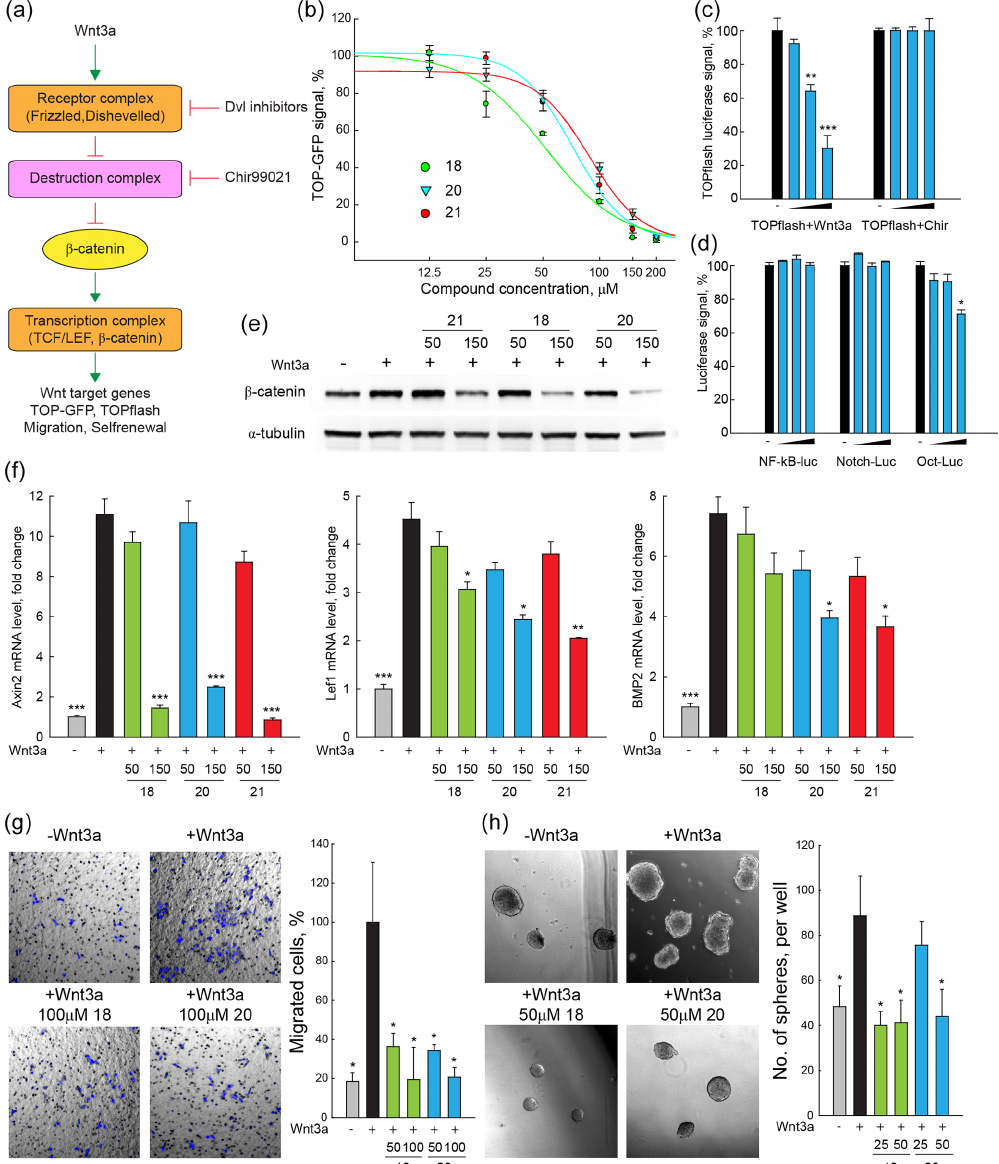
Figure 2. DVL inhibitors antagonize Wnt signalling and Wnt-related properties of cancer cells induced by Wnt3a. (a) Scheme of Wnt signalling pathway. Important components of the Wnt signalling pathway are schematically presented. Wnt3a treatment increases the tran- scription of Wnt targets, enhances signals of TOP-GFP and TOPflash assays, and promotes Wnt-related biological properties of cancer cells. (b) TOP-GFP reporter assays were performed with HEK293 reporter cell line. Compounds 18 , 20 , and 21 inhibited Wnt3a-induced Wnt ac- tivation in a dose-dependent manner with IC 50 of 50–75µM. (c, d) TOPflash assays stimulated with Chir99021 and reporter assays of other pathways were used to evaluate the specificity of compound 20 . Compound 20 specifically inhibited Wnt3a-induced Wnt activation and had no or a mild effect on Chir99021-induced Wnt activation and other signalling pathways including NF– κ B, Notch, and Oct4. (e) β -Catenin protein levels were detected with Western blotting in HeLa cells. Compounds 18 , 20 , and 21 (150µM) inhibited accumulation of β -catenin in HeLa cells treated with Wnt3a. (f) The mRNA levels of Wnt target genes (Axin2, LEF1, and Bmp2) in HeLa cells were measured with quantitative real-time PCR. Compounds 18 , 20 , and 21 (150µM) reduced the transcription of Wnt target genes that are enhanced by Wnt3a treatment in HeLa cells. (g) Cell migration of SW480 cells after Wnt3a treatment was assessed by trans-well assays. Compounds 18 and 20 (50–100µM) reduced the migration of SW480 cells enhanced by Wnt3a. (h) SW480 cells were cultured in serum-free non-adherent conditions to evaluate the self-renewal property enhanced by Wnt3a treatment. Compounds 18 and 20 (25–50µM) reduced sphere formation of SW480 cells that was enhanced by Wnt3a treatment. For all tests, three independent biological replicas were performed and error bars represent standard deviations. P values were calculated from t test. ∗ : P < 0 . 05; ∗∗ : P < 0 . 01; ∗∗∗ : P < 0 . 001.